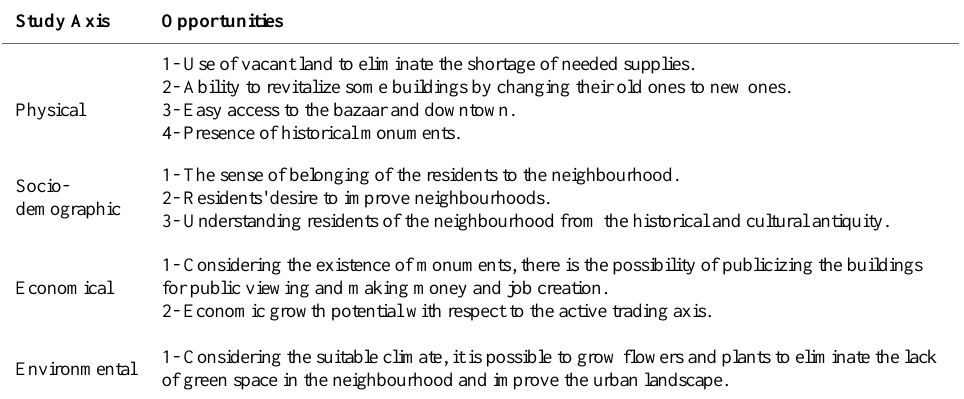
Table 3. Analysis of the opportunities of the Neighbourhoods using the SWOT